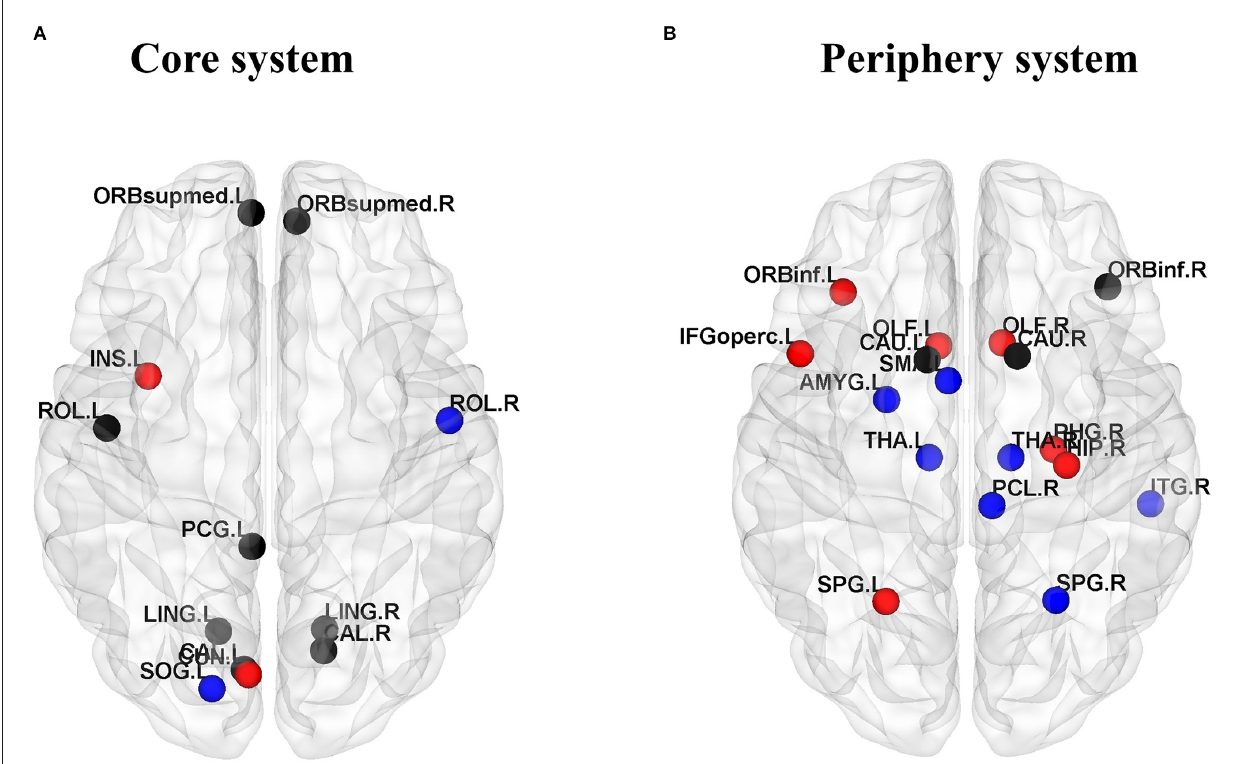
FIGURE6 Consistent and inconsistent core-periphery system between the healthy control groups and the JME groups. (A) Core system. (B) Periphery system. Among them, the black nodes represent common nodes in two groups, the blue nodes represent nodes specific to the HC, and the red nodes represent nodes specific to the JME patients.